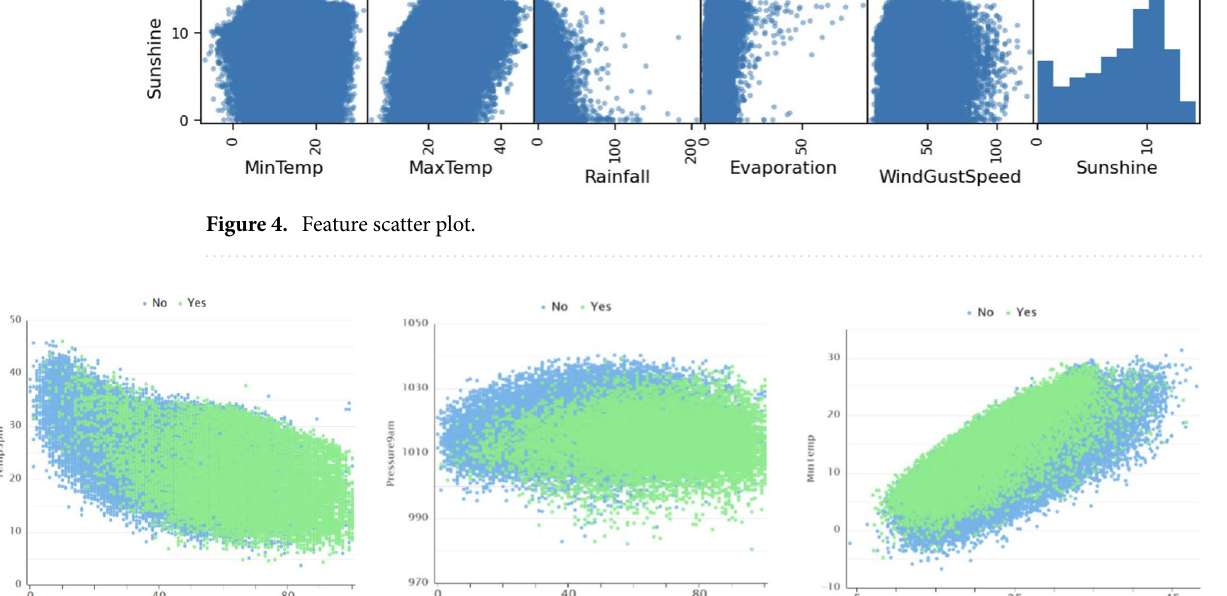
Fig. 9, we perform subset selection and find optimal subset to minimize BIC and Cp and maximize adjusted.